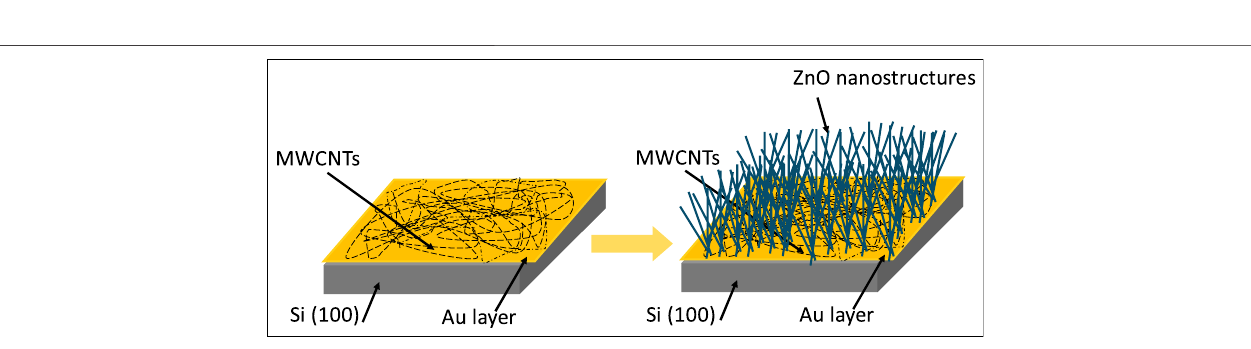
Frontiers in Materials |